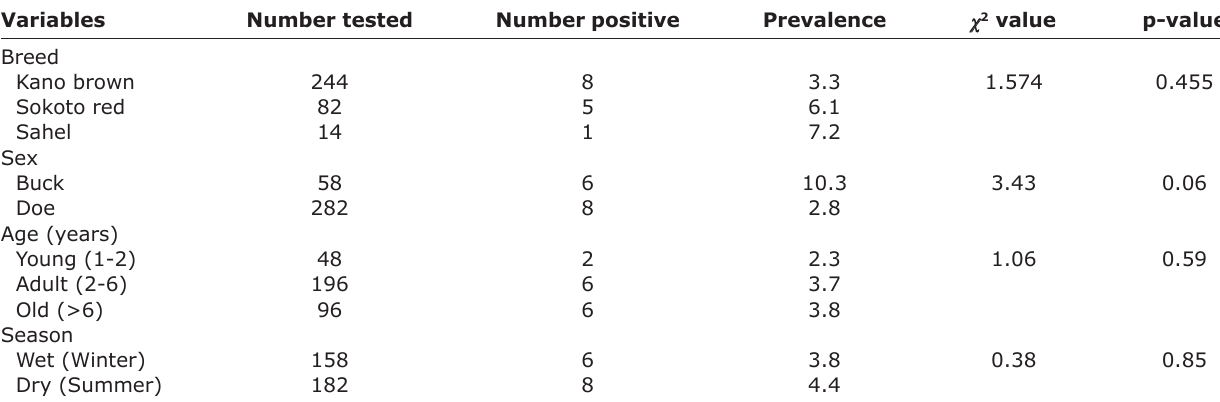
Table-3: Breed, sex, age and seasonal distribution of Brucella antibody in goats (n=340) surveyed in Enugu State, Nigeria.